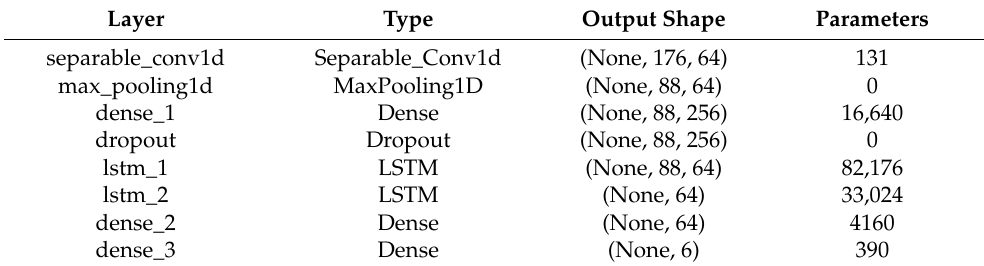
Table 1. Parameters of the DSCNN–2LSTM